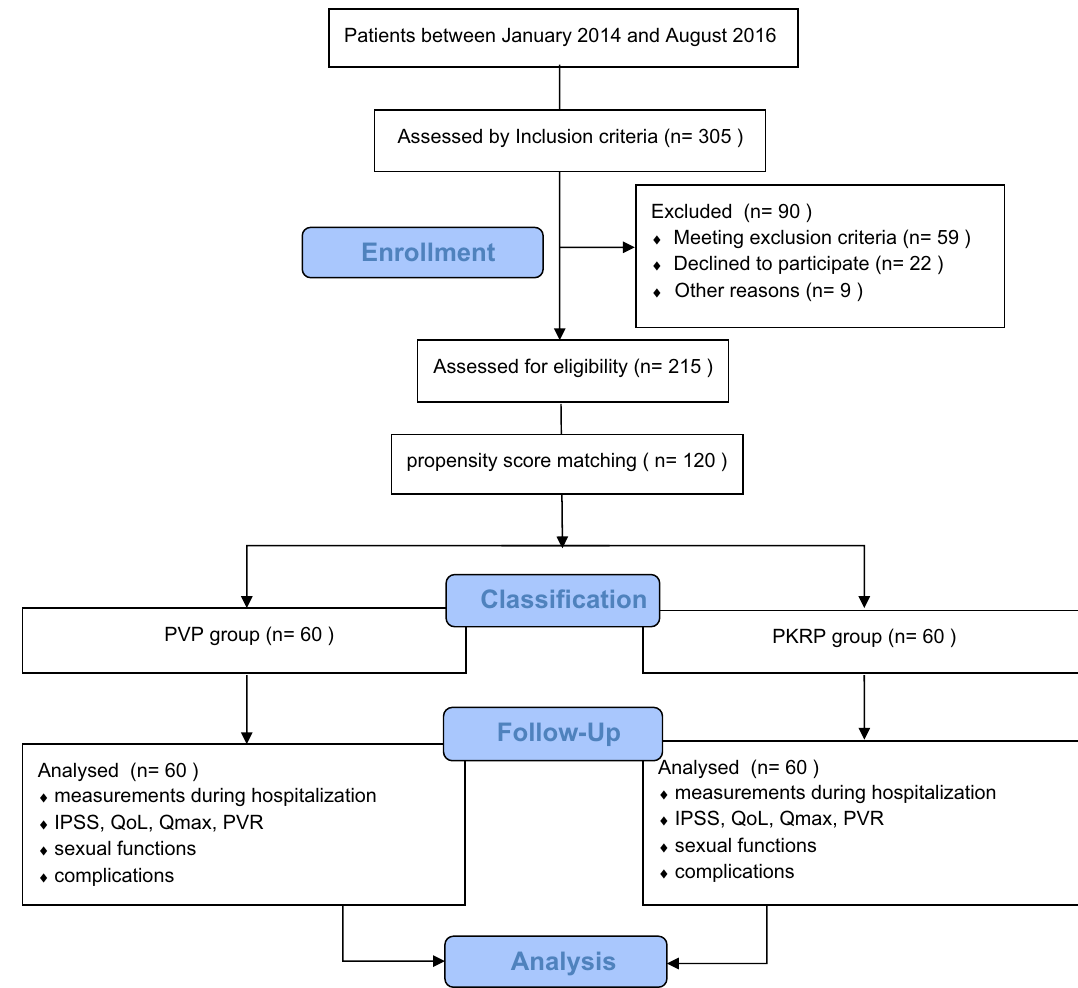
Figure 1. Flow diagram depicting cohort formation, treatment and follow-up of